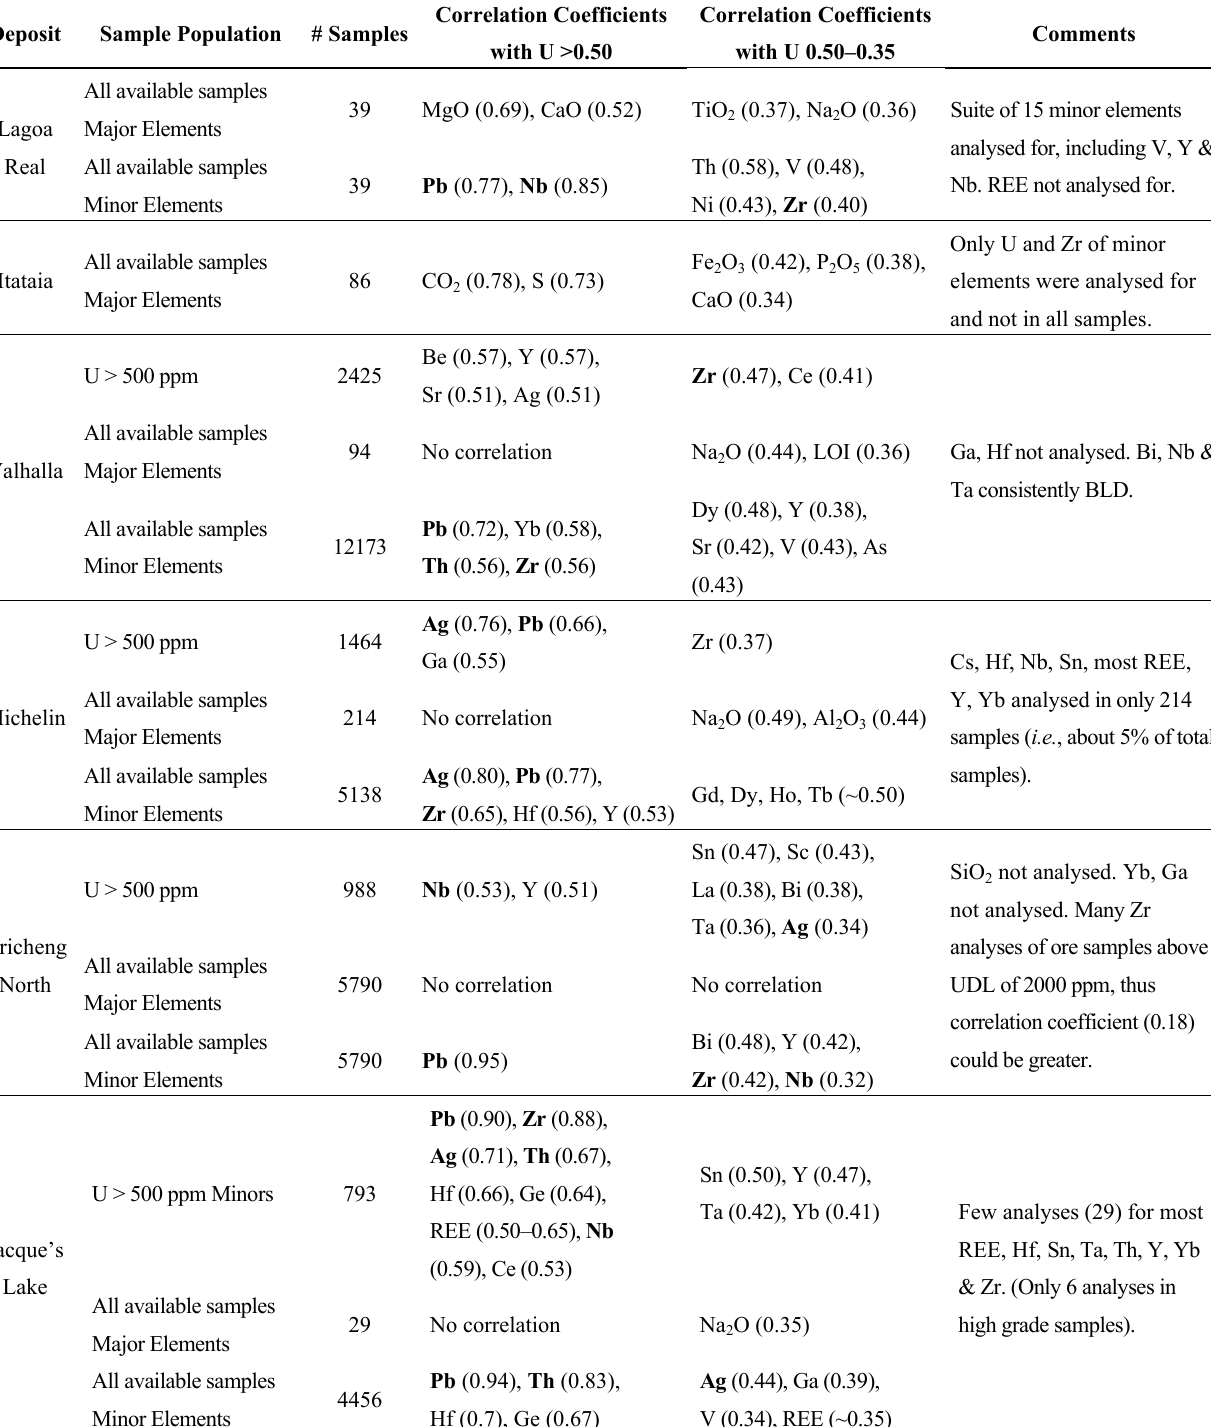
Table 2 . Summary of bulk chemical characteristics of selected albitite-type uranium deposits. (Paladin Energy unpublished data, except Lagoa Real and Itataia [9,21]. Note that analytical suites, methods and detection limits vary between